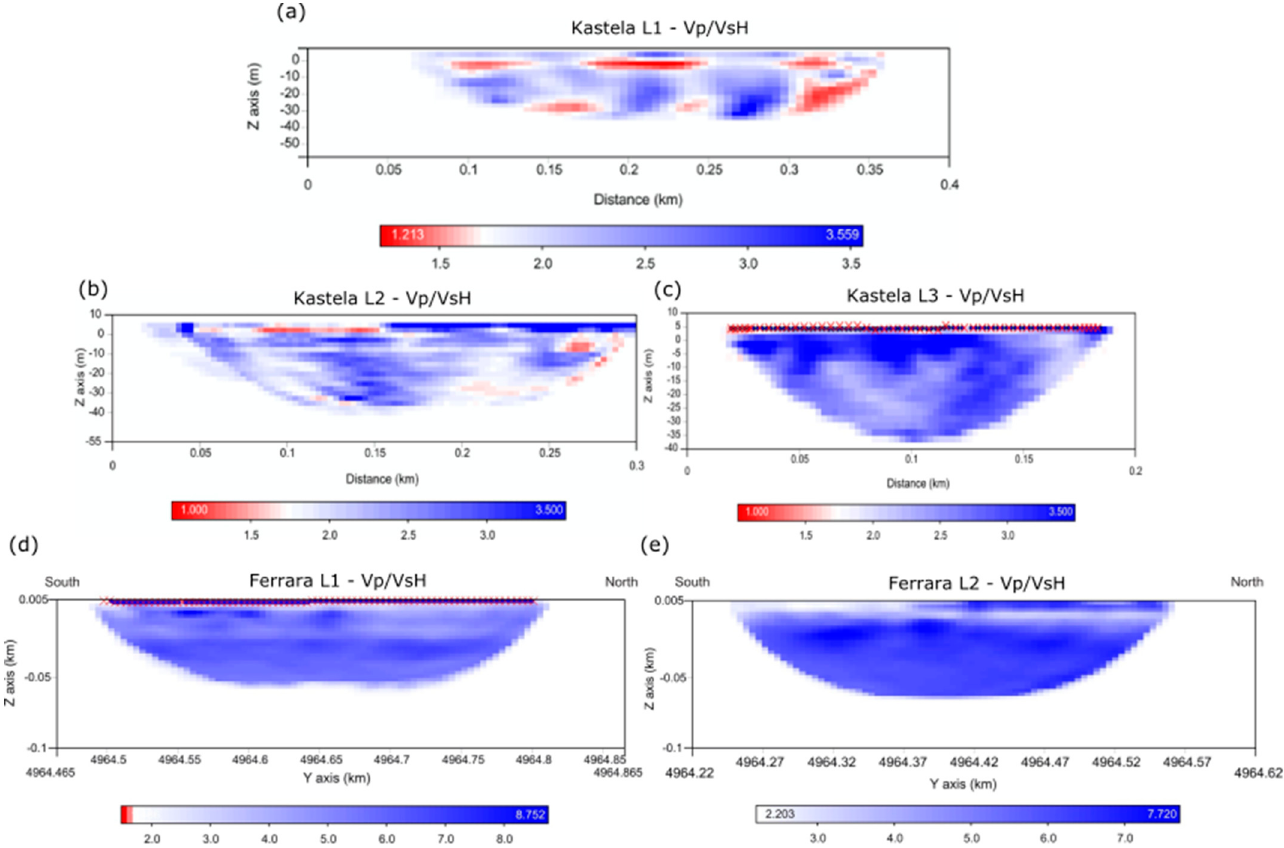
Figure 6. V P /V SH ( a ) Kaštela Line 1. ( b ) Kaštela Line 2. ( c ) Kaštela Line 3. ( d ) Ferrara Line 1. ( e ) Ferrara Line 2.